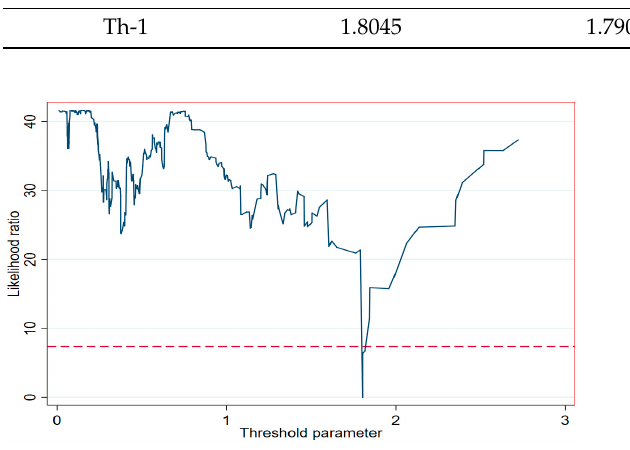
Figure 5. Likelihood ratio